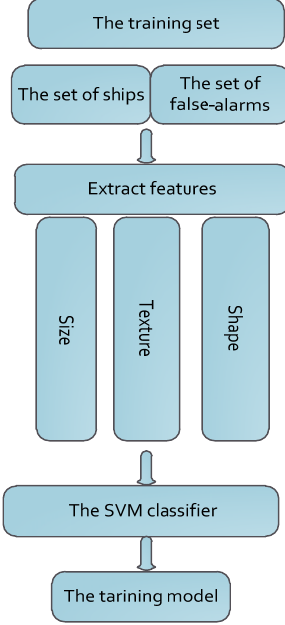
Figure 12. The flowchart of the support vector machine (SVM) training process.